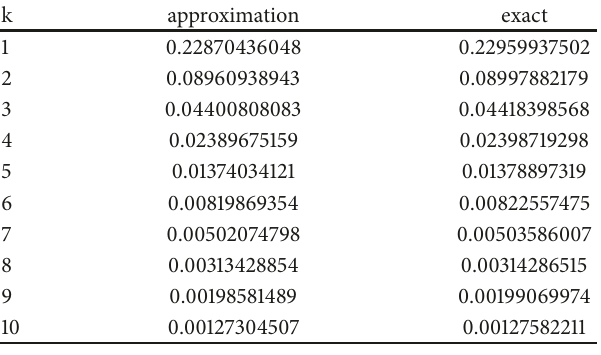
Table 2: Reasonable approximation using